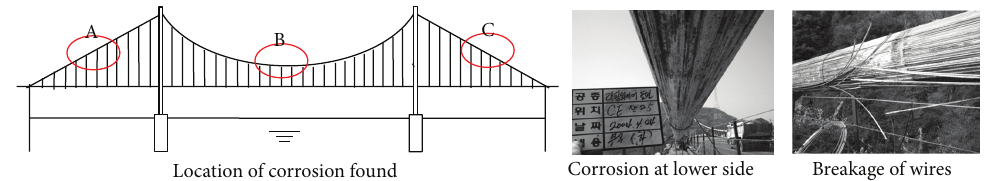
Figure 3: Inspection of the main suspension cables of the Nam-Hae Bridge [9].